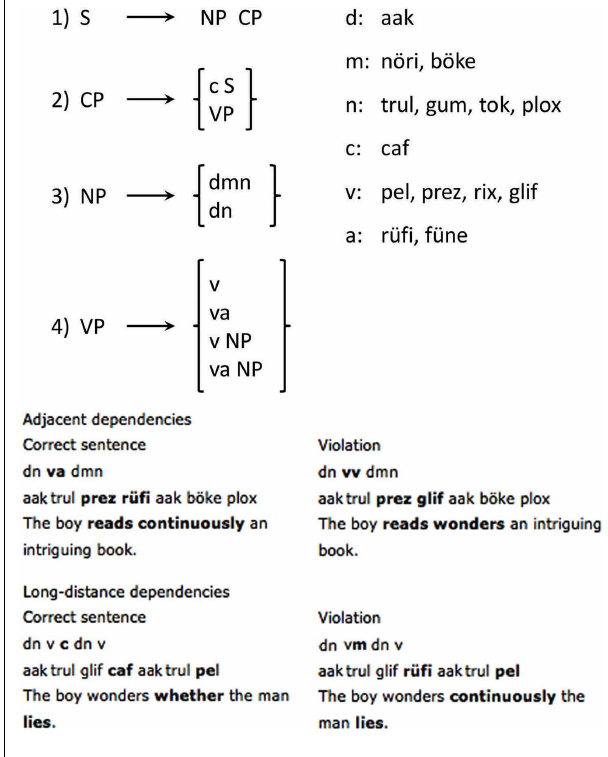
FIGURE 1 | Schematic illustration of the rules underlying the artificial language BROCANTO. Capital letters represent non-terminals: NP, noun phrase; CP, complementizer phrase;VP, verb phrase.Terminal symbols are depicted as lower case letters: d, determiner; m, modifier (adjective); n, noun; v, verb, a, adverb; c, complementizer.The vocabulary is depicted on the right. Below, examples of adjacent and long-distance dependencies in BROCANTO along with literal English counterparts are given.The respective dependencies are marked in